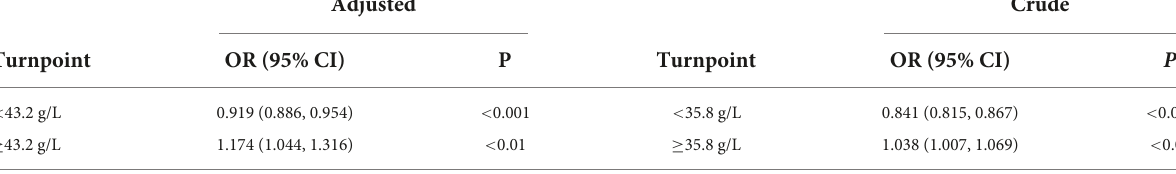
TABLE 2 Threshold effect analyses of serum albumin levels on mortality using two piecewise regression